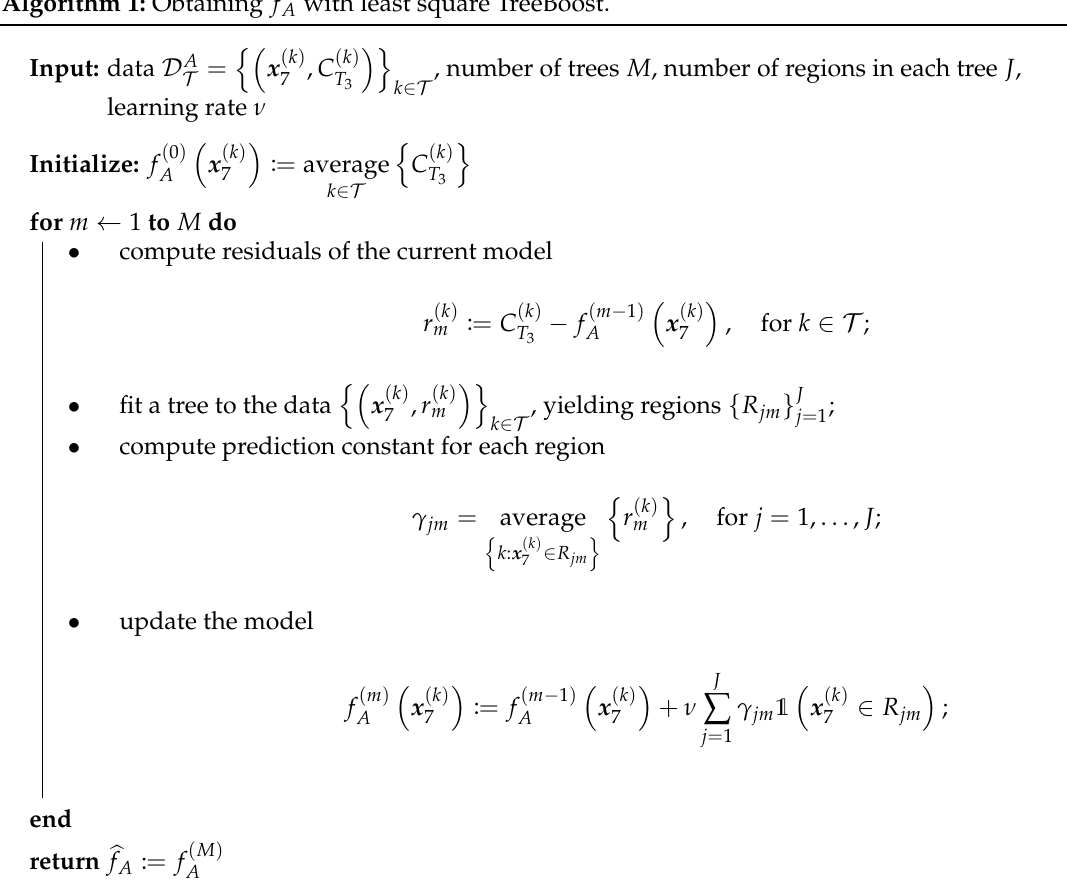
Algorithm 1: Obtaining (cid:98) f A with least square TreeBoost.